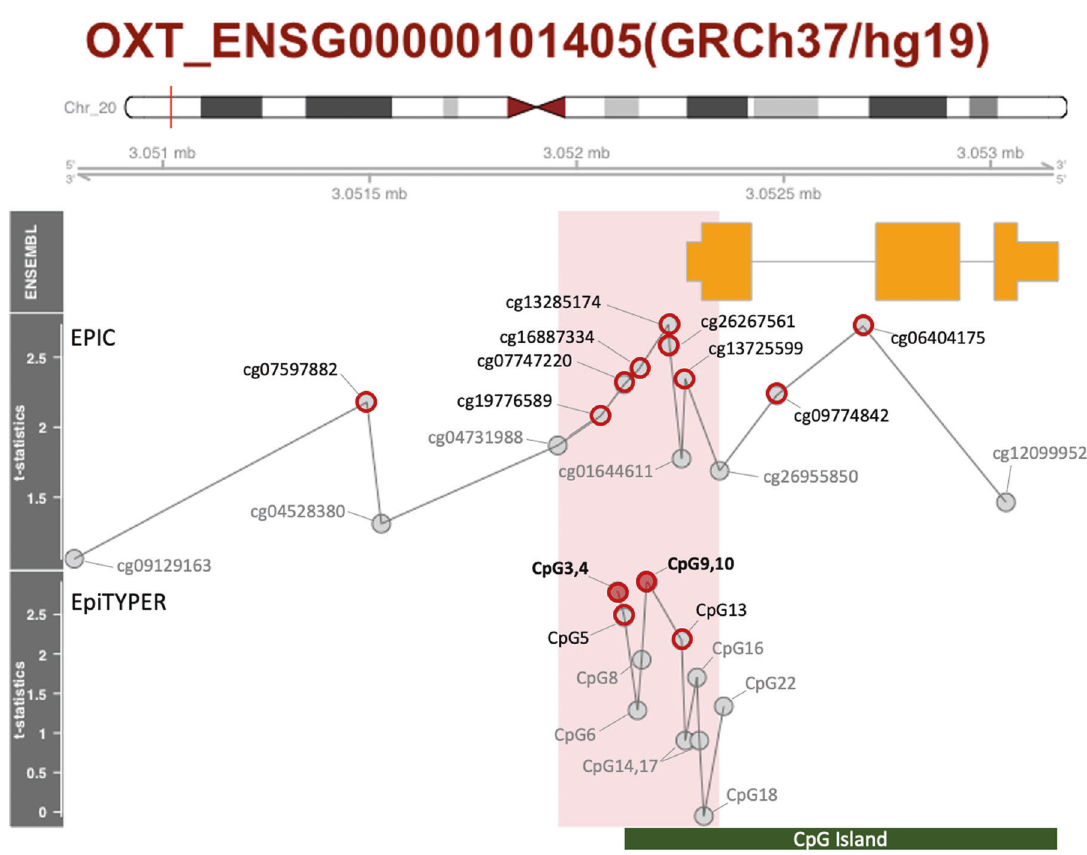
Fig. 1 Localization and structure of the OXT gene on chromosome 20 (GRCh37/hg19) and the location of the CpG probes from EPIC (upper) and CpG fragments from EpiTYPER (lower). The t statistics represent the results of multiple regression analyses between each CpG and child maltreatment. Closed and open red circles represent FDR < 0.05, and FDR < 0.10, respectively. The light pink shaded area represents the clustered region de fi ned by a factor